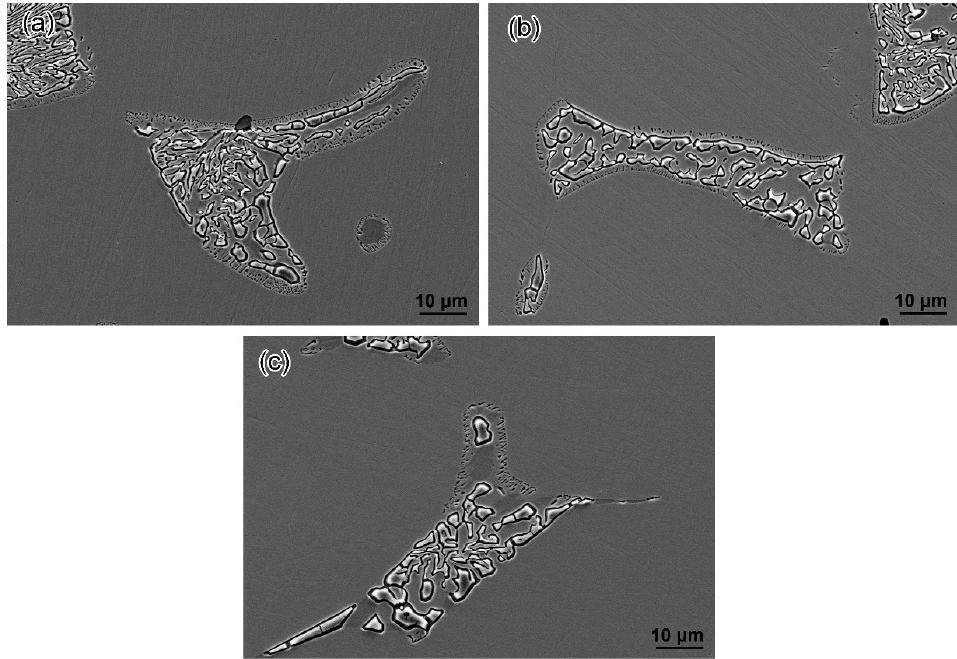
Figure 9. Higher magnification SEM microstructures of Z3CN20.09M specimens aged at 750 °C for different durations: ( a ) 50 h, ( b ) 100 h, ( c ) 200 h.